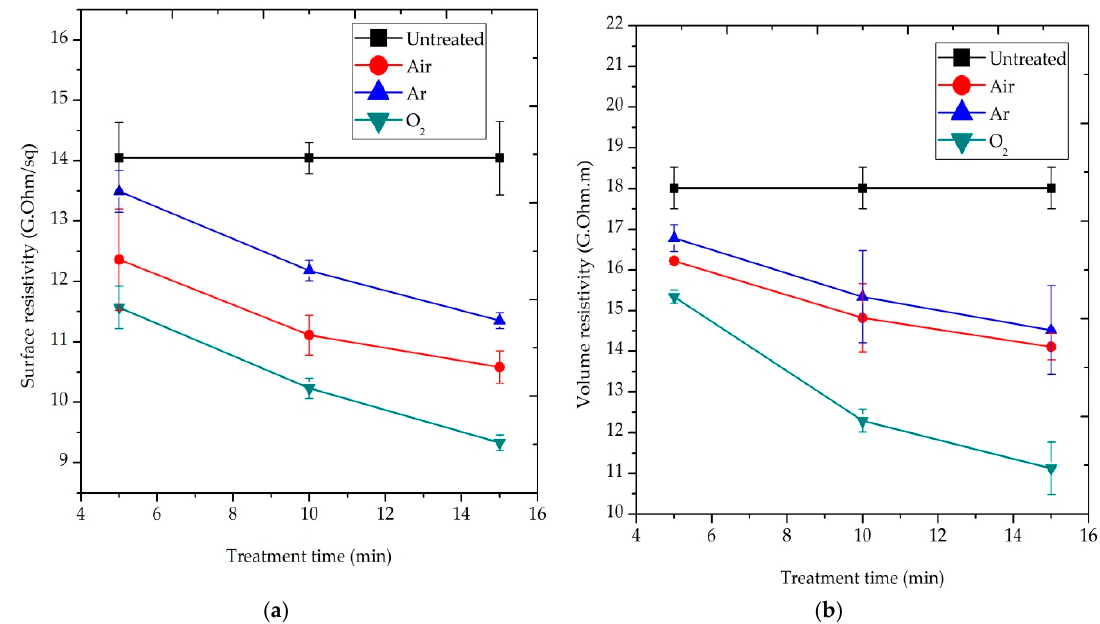
Figure 5. Effect of the treatment time on: ( a ) surface resistivity ( ρ s ) and ( b ) volume resistivity ( ρ v ) of P/C blend fabric.